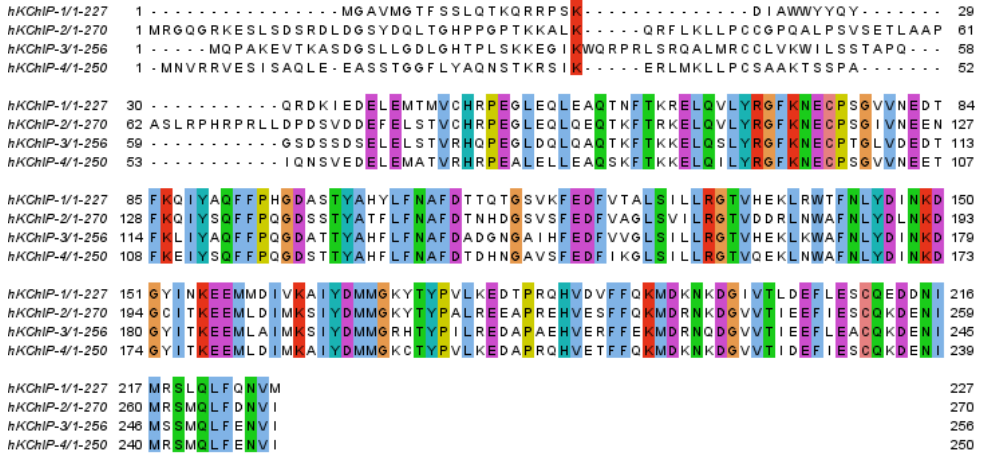
Figure 2. Alignment of human KChIPs. Alignment with ClustalO within Jalview. Residues that are identical in the four sequences are boxed